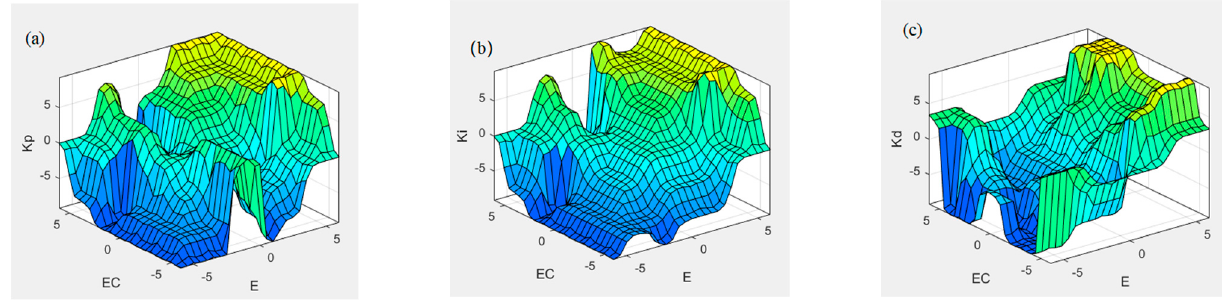
Figure 6. Fuzzy logic controller surface: ( a ) surface of ∆K (cid:2900) ; ( b ) surface of ∆K (cid:2919) ; ( c ) surface of ∆K (cid:2914) .